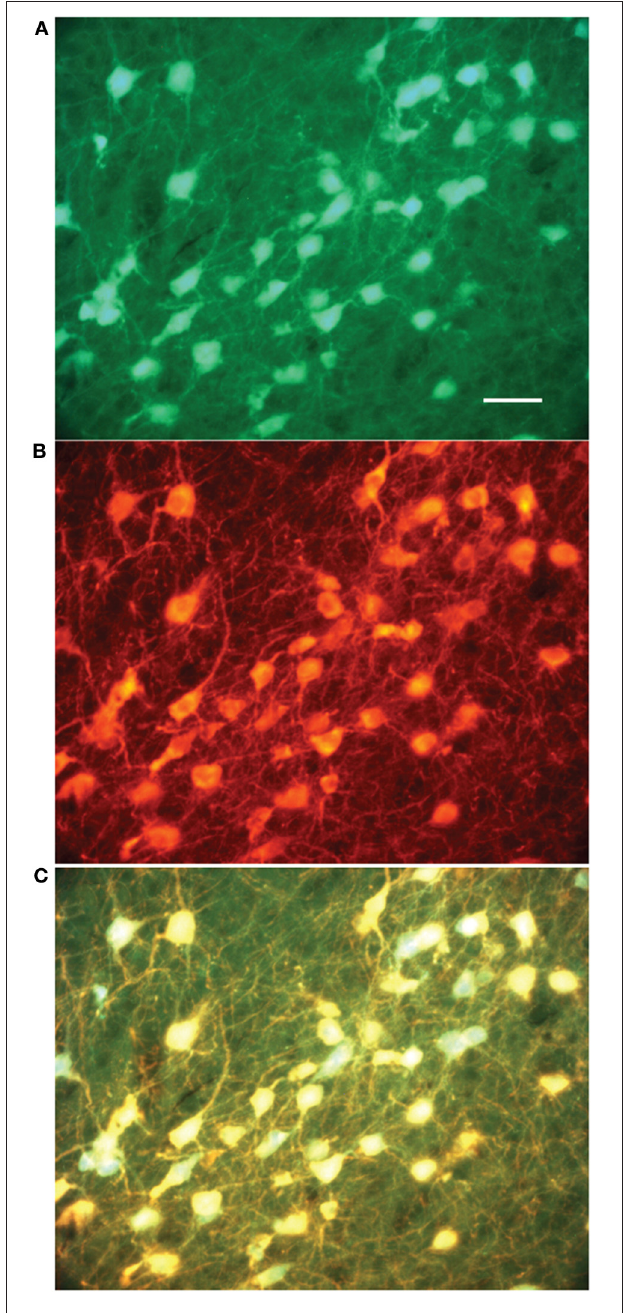
FIGURE 1 | Colocalization of GFP expression and ChAT immunocytochemistry in the substantia innominata. (A) GFP expression, (B) ChAT immunostaining, (C) Overlay of (A) and (B) shows that all GFP expressing cells are stained with an antibody against ChAT. Bar scale: 50 μ